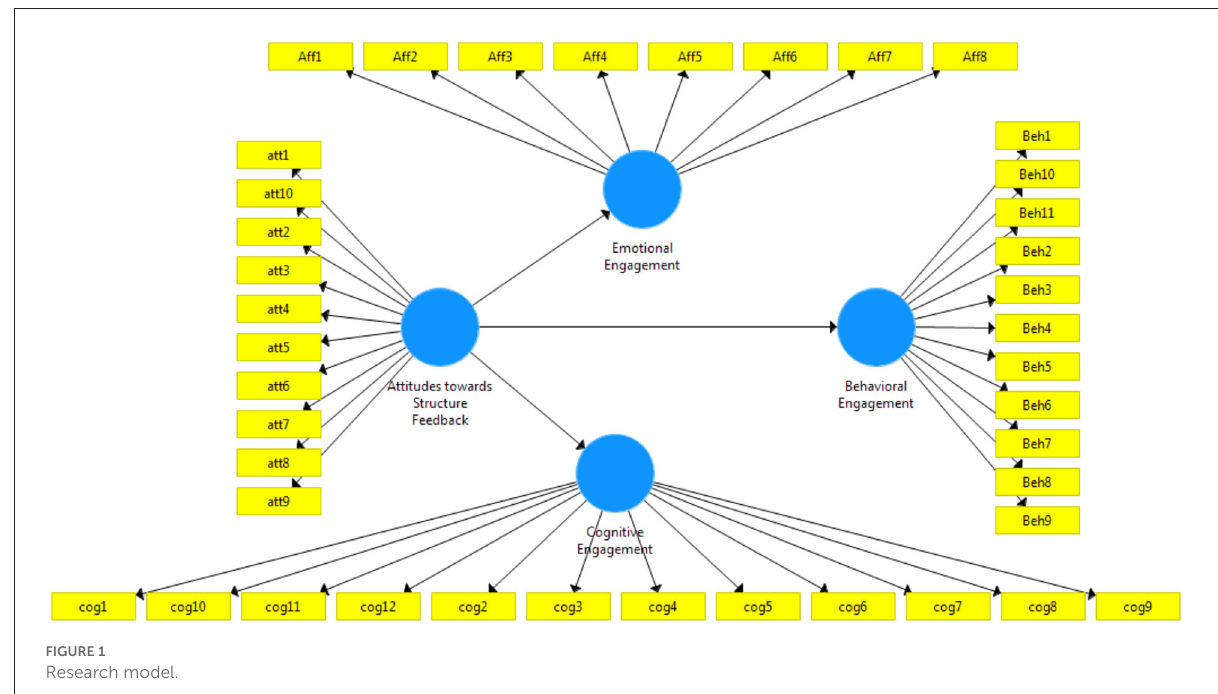
FIGURE1 Research